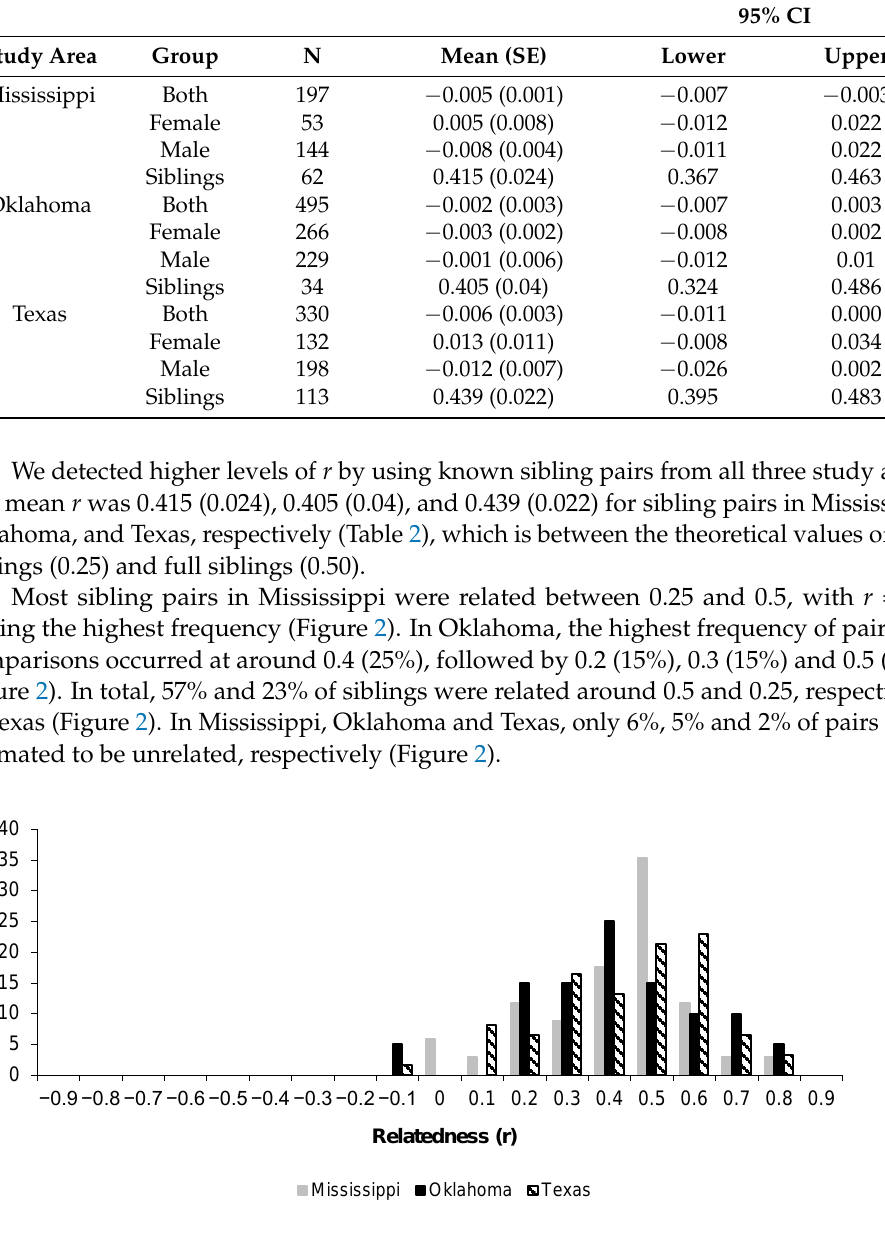
Table 2. Relatedness ( r ) of females, males, sibling pairs, and both sexes combined in white-tailed deer ( Odocoileus virginianus ) from Mississippi (1999–2001), Oklahoma (1991–2005) and Texas (1999–2005). 95% CI Study Area Group N Mean (SE) Lower Upper Mississippi Both 197 − 0.005 (0.001) − 0.007 − 0.003 53 0.005 (0.008)